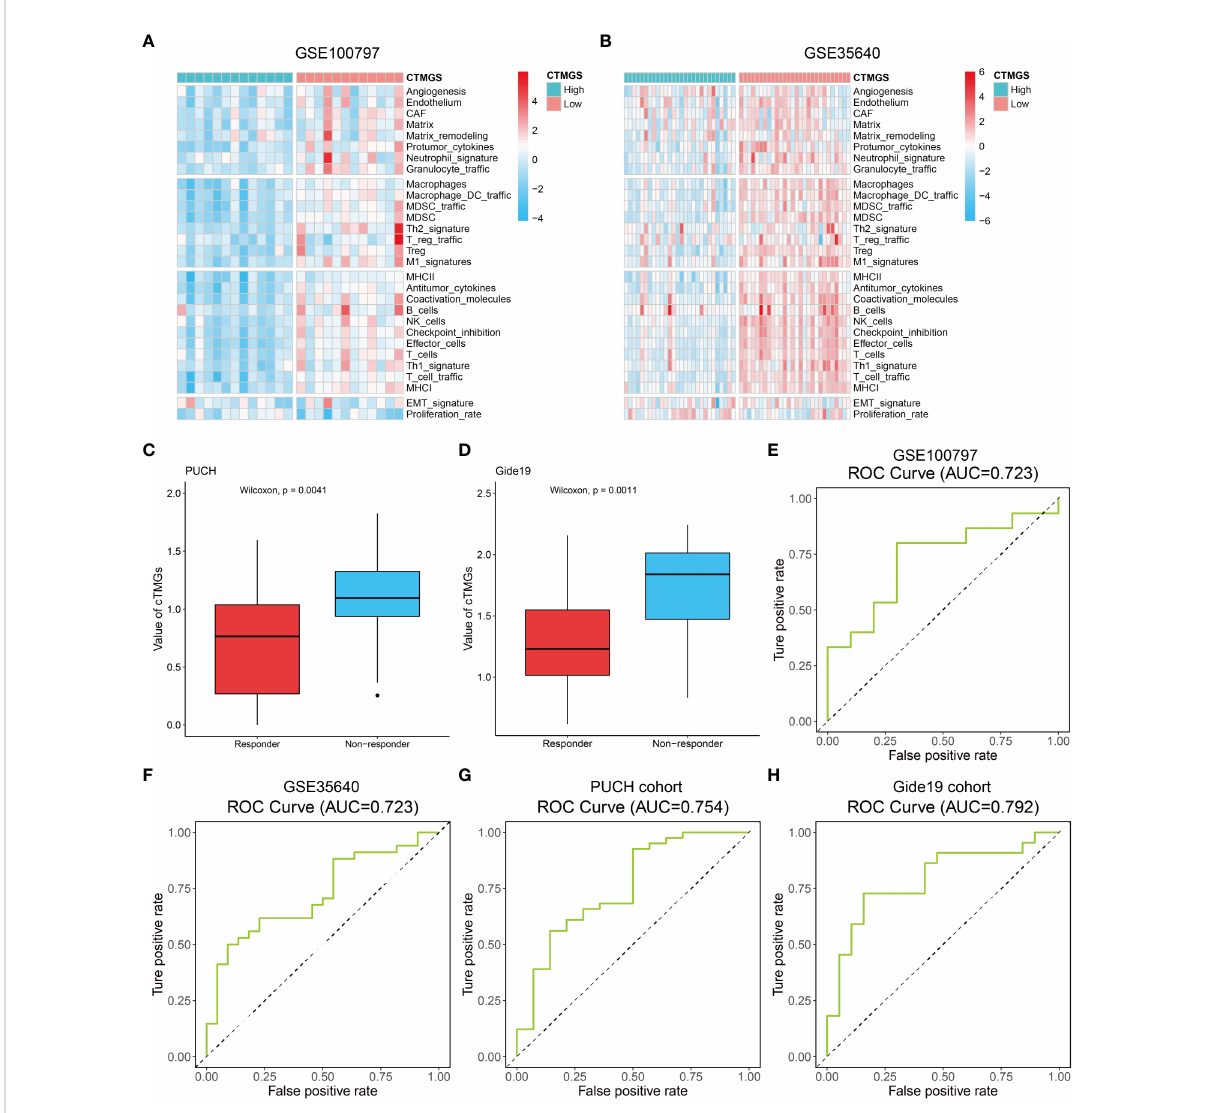
FIGURE 6 Performance of the cTMGs for predicting the effect of ICI therapy on CM patients. (A, B) Enrichment analysis of the 29 Fges of CM patients from the GSE100797 (A) and GSE35640 (B) dataset. (C, D) cTMGs value of CM patients receiving anti-PD-1 monotherapy in the PUCH cohort (C) or Gide19 cohort (D) . (E – H) ROC curve showing the performance of the cTMGs for predicting the effect of immunotherapy on CM patients in the GSE100797 (E) , GSE35640 (F) dataset, PUCH cohort (G) , or Gide19 cohort (H)